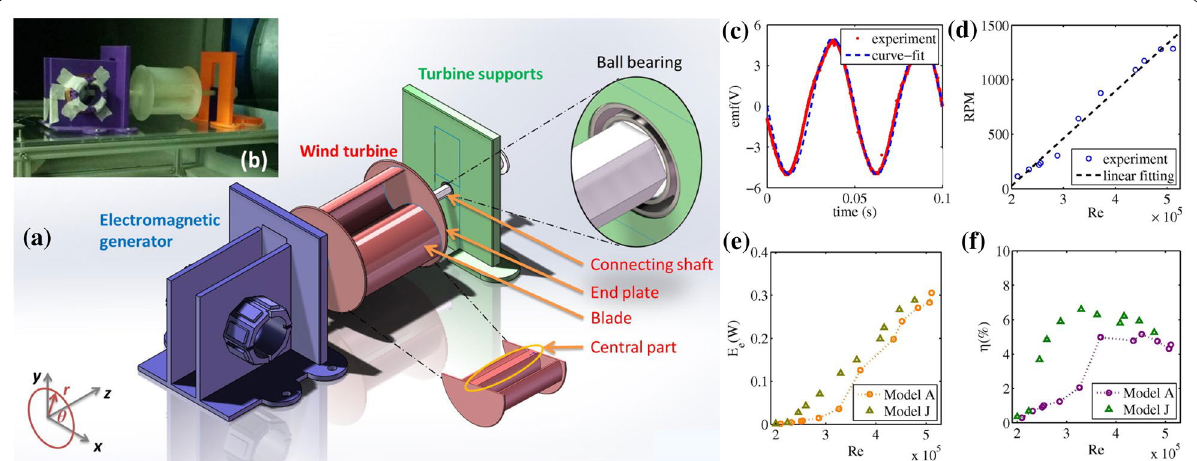
Fig. 8 a CAD model of the air-driven 3D printed EMG energy harvester, b prototype for the experimental testing in the wind tunnel c output voltage with time d RPMs with Reynolds number (Re) e output power with Re f energy conversion efficiency with Re [26] (Images are re-used with the permission of the